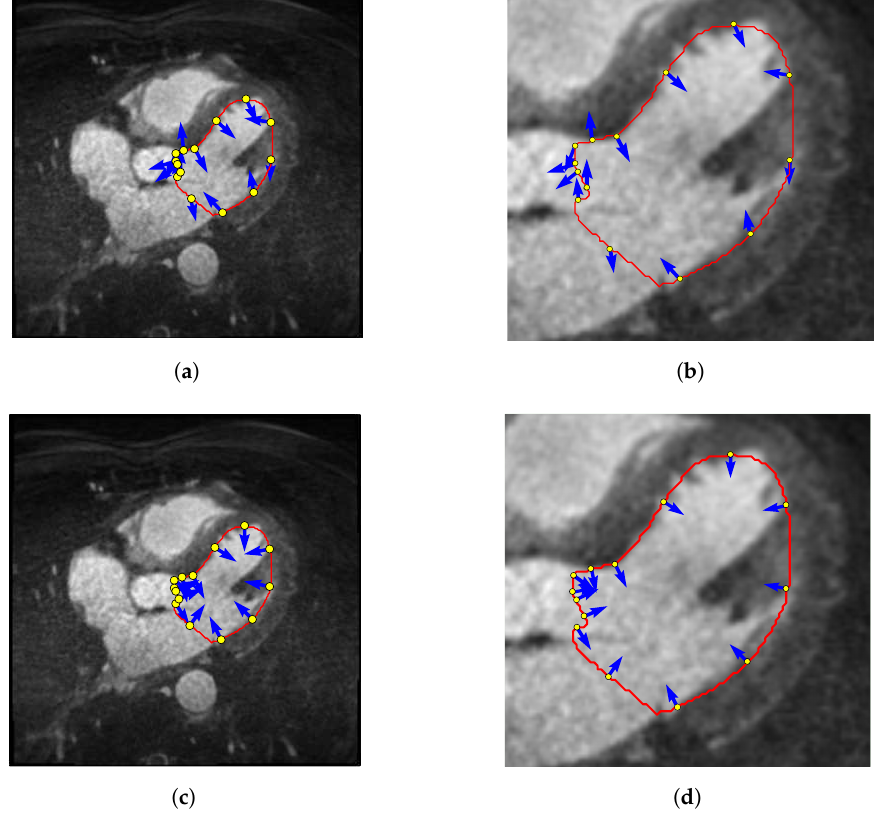
Figure 11. Normal vector orientation for left ventricle segmentation with an ambiguous boundary: ( a , b ) control points (yellow) and associated normal vectors (blue) based on intensity gradients for the HRBF method; ( c , d ) control points (yellow) and associated normal vectors (blue) based on the drawn contour (red) for our proposed method ([2], Reproduced with